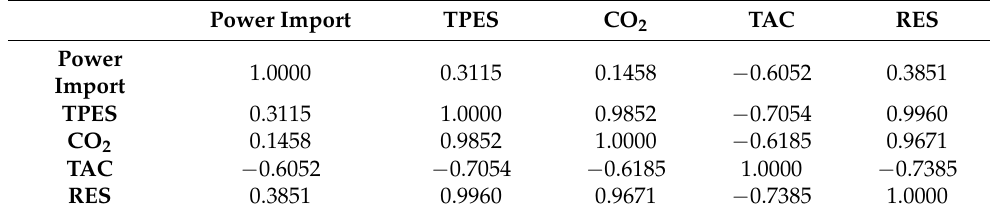
Table 5. Correlation coefficient between the